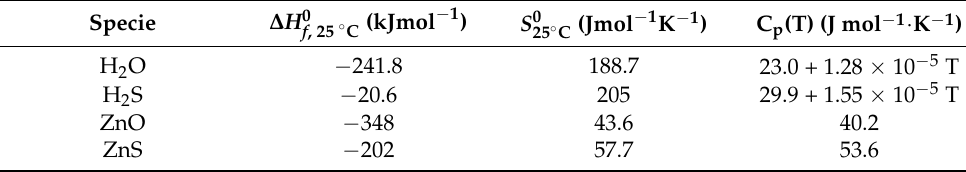
Table 4. Thermodynamic parameters for the hydrogen sulphide